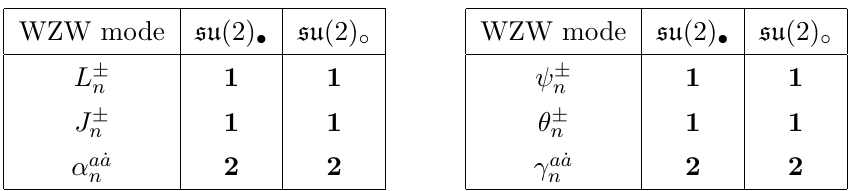
Table 7 . We list so (4) 2 = su (2) (cid:15) (cid:8) su (2) (cid:14) charges for worldsheet bosons and fermions respectively in the left and right